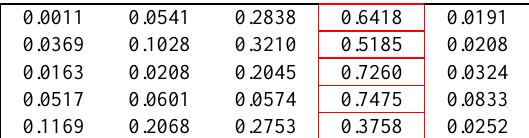
Figure 4. First output of each